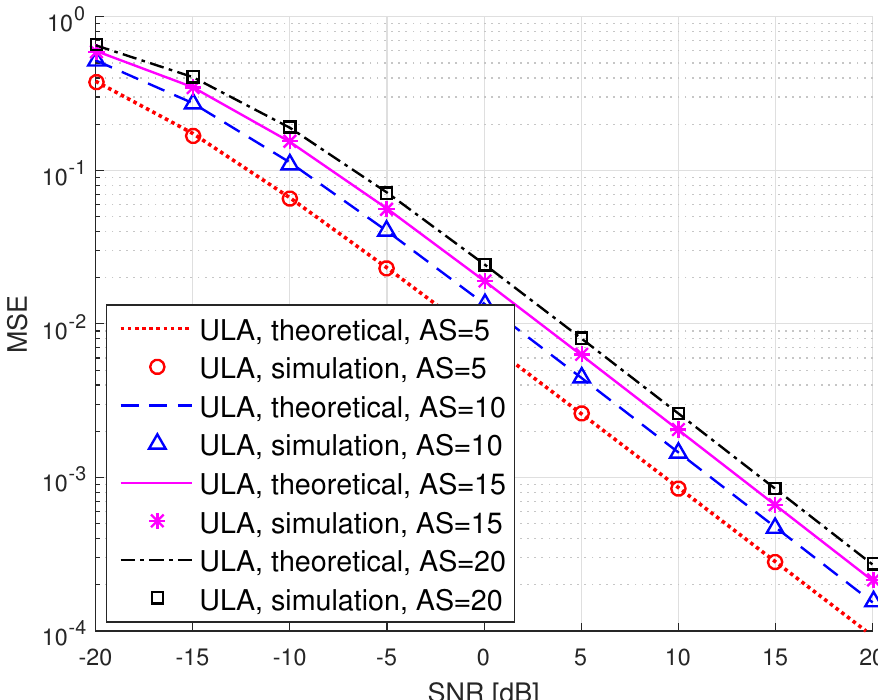
Figure 6. MSE vs. SNR in dB for the ULA topology, U = 10 UEs, M = 128, with different values of angular spread α A ( AS ) .